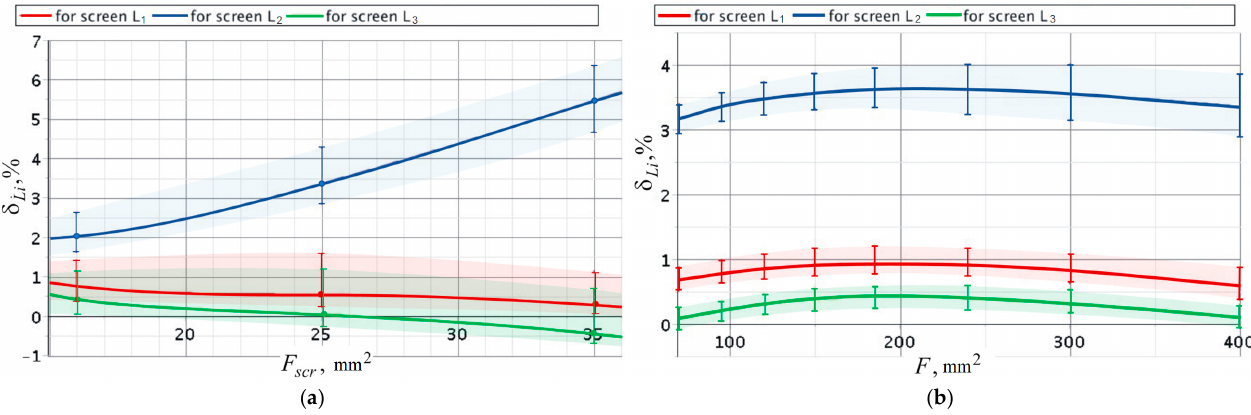
Figure 6. Dependences of the error δ on cross-section of cable screen ( a ) and cross-section of cable core ( b ) for three lines: L 1 (red), L 2 (blue) and L 3 (green).